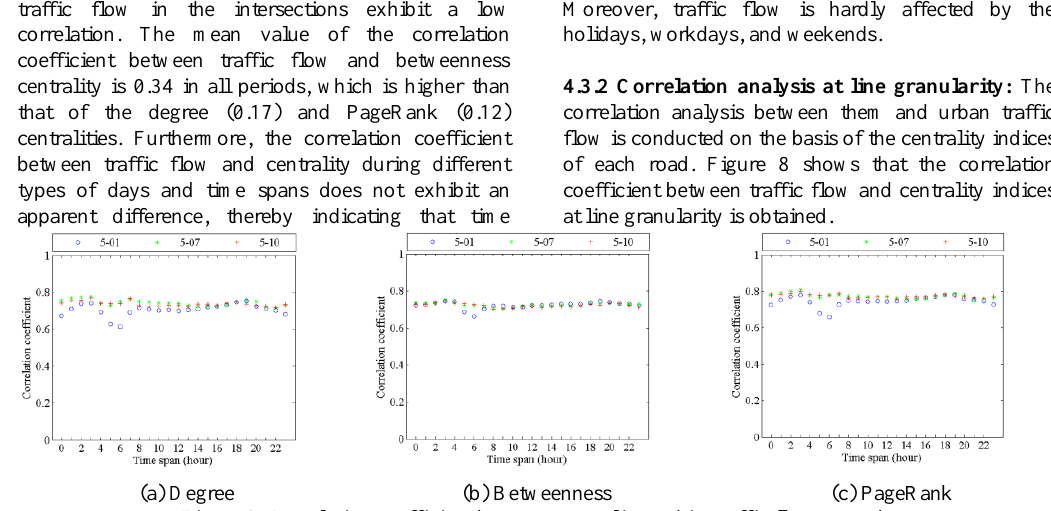
Figure 8. Correlation coefficient between centrality and its traffic flow at roads